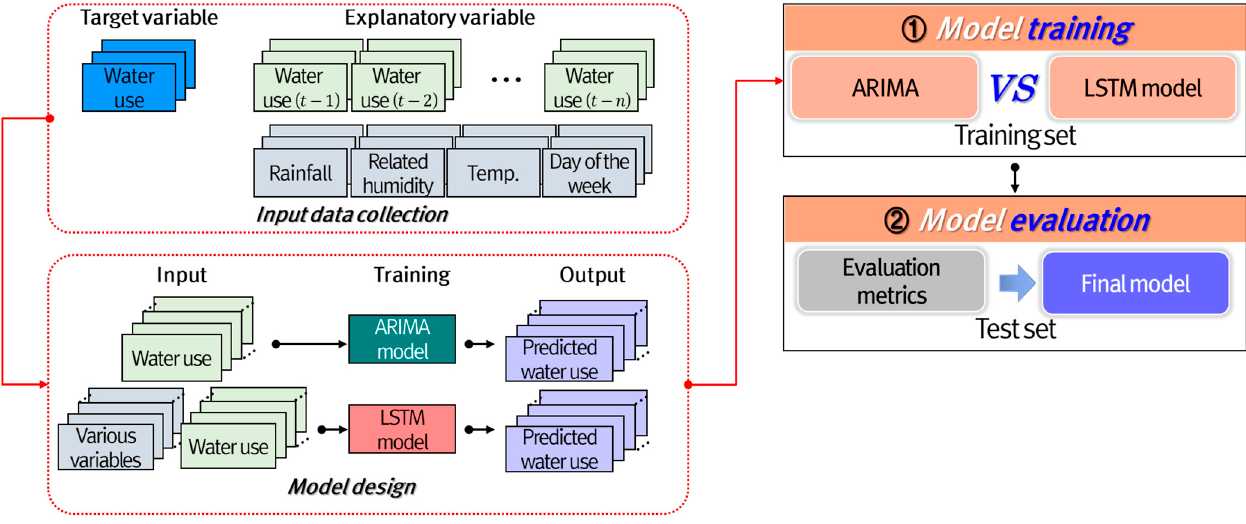
Figure 3. Monthly patterns of three meteorological data (rainfall, relative humidity, and temperature).